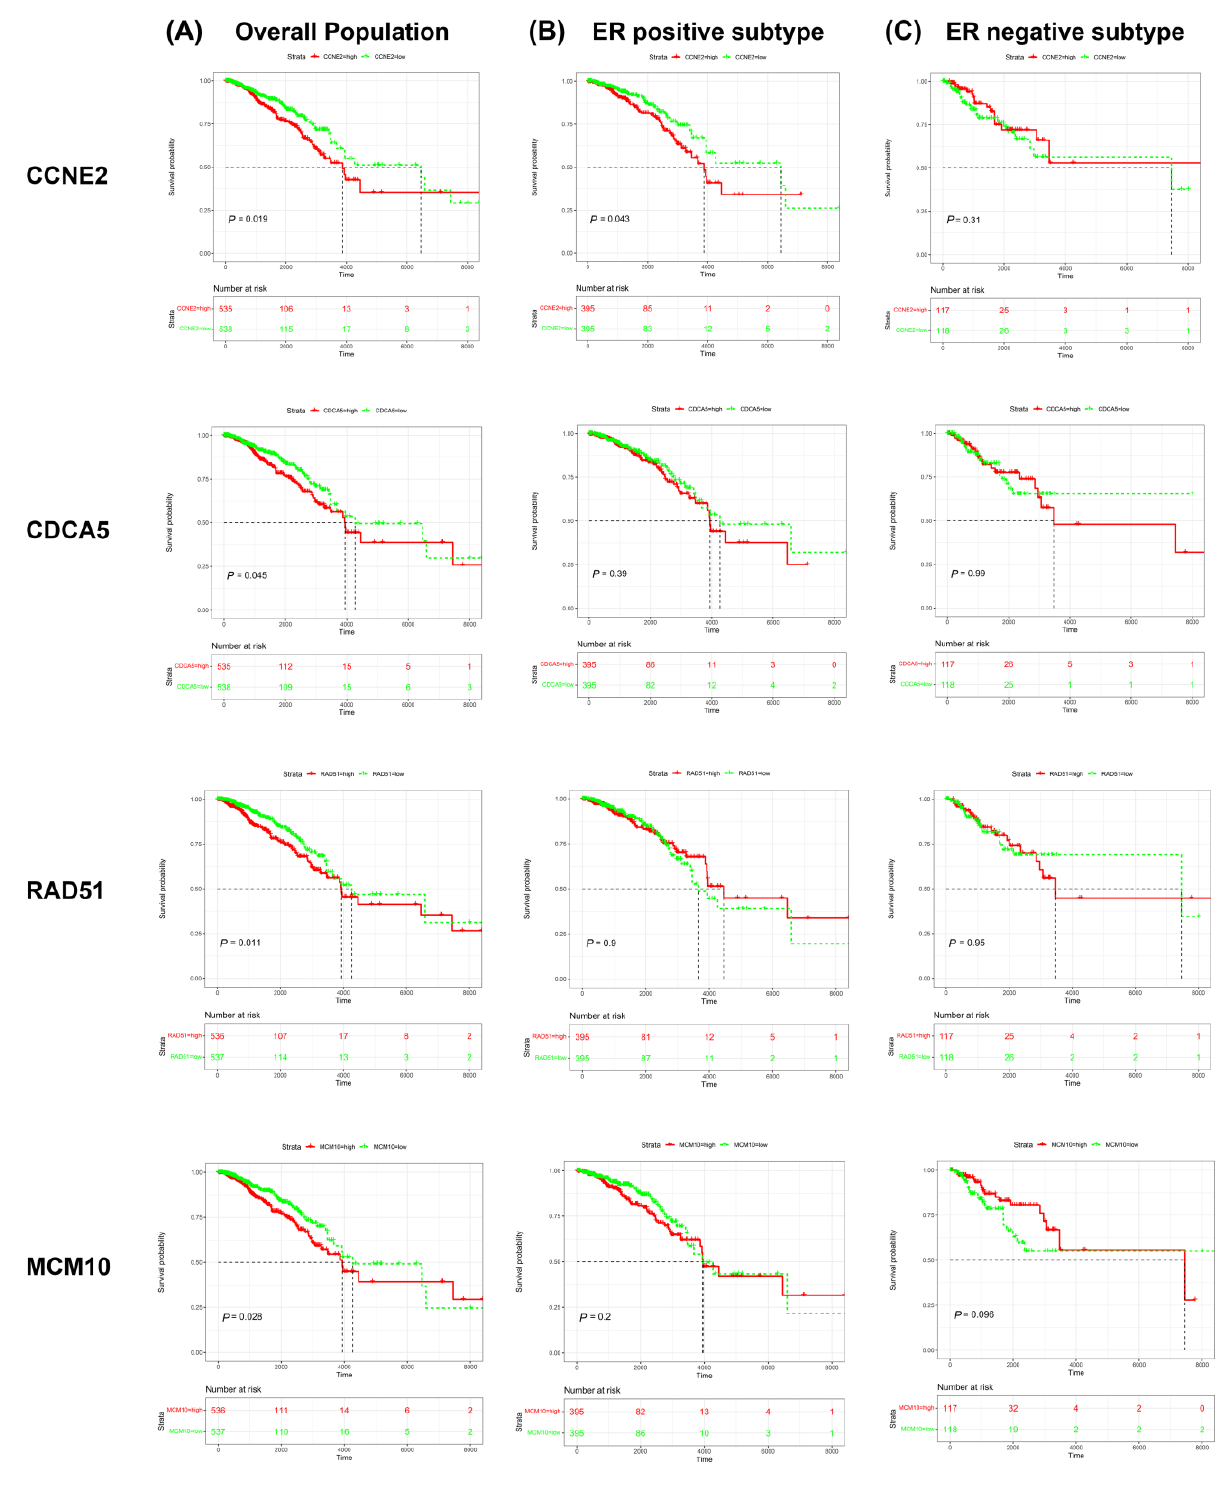
Figure 6. Kaplan – Meier survival curve analysis of the candidate genes ( CCNE2, CDCA5, RAD51, and MCM10 ) in breast cancer patients. ( A ) Survival curve for all breast cancer patients. ( B ) Survival curve for ER-positive breast cancer patients. ( C ) Survival curve for ER-negative breast cancer patients. Abbreviation: ER, estrogen receptor.